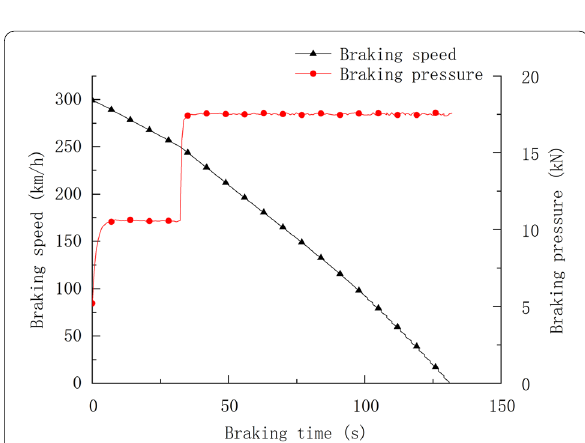
Figure 5 Change of braking pressure with speed at initial speed of 300 km/h